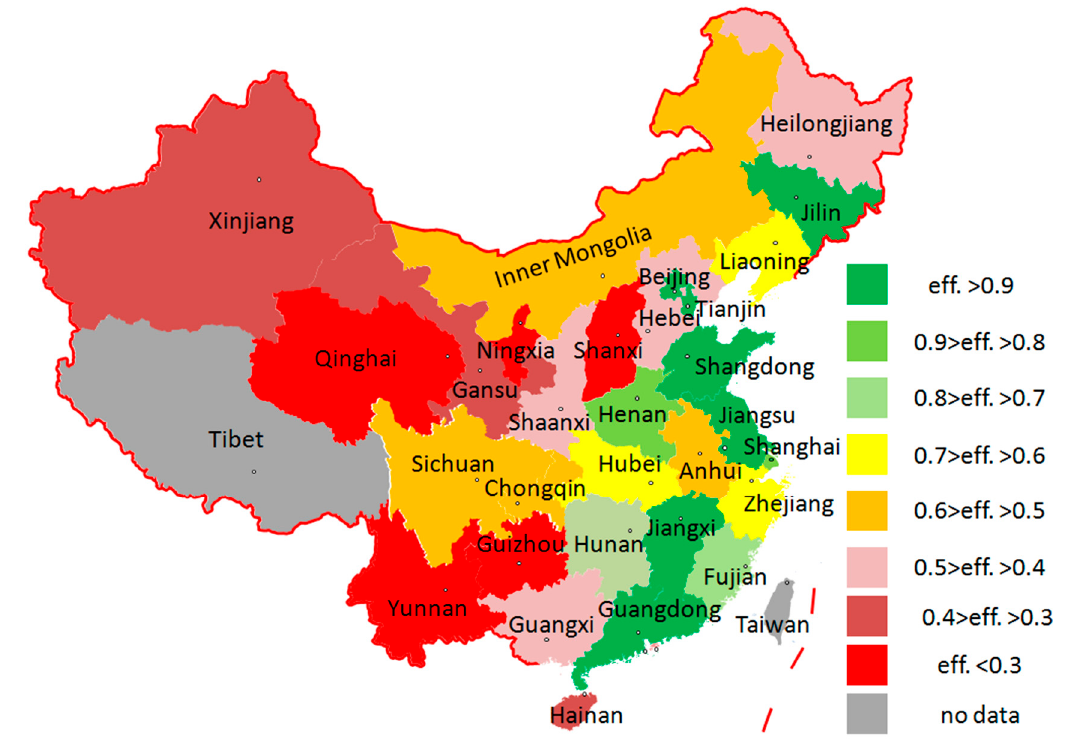
Figure 8. Valuesmeasured by SBM method.